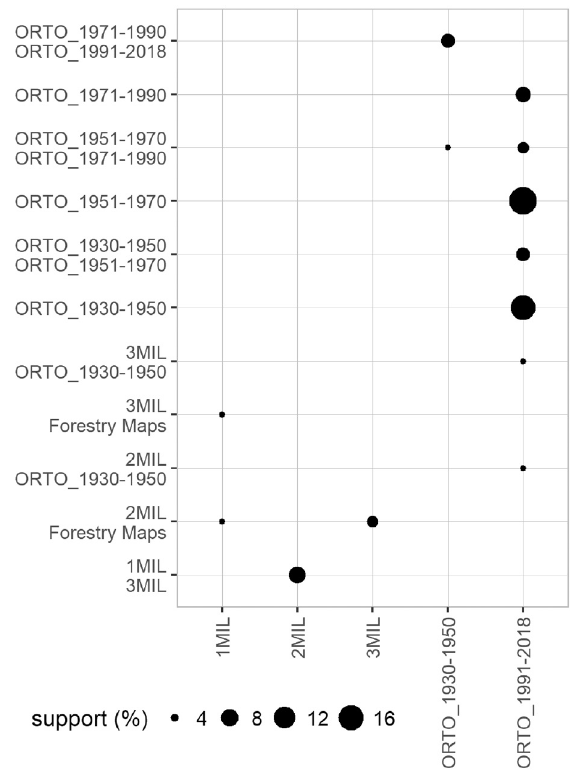
Fig. 8. Association between map and data sources. MIL – Military mapping, ORTO – orthophoto/aerial